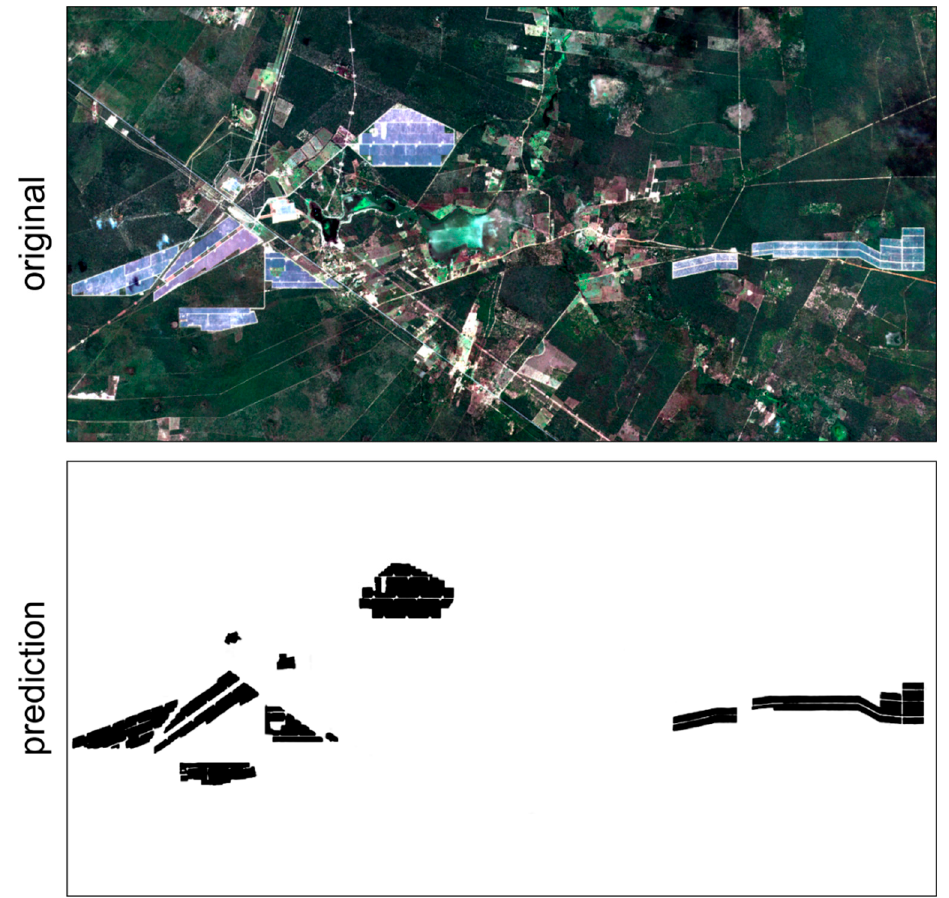
Figure 5. Mosaic representation on a 1536 × 768-pixel image with the original image, the correspond- ing ground truth (GT), and prediction using the U-net with Efficient-net-b7 backbone.